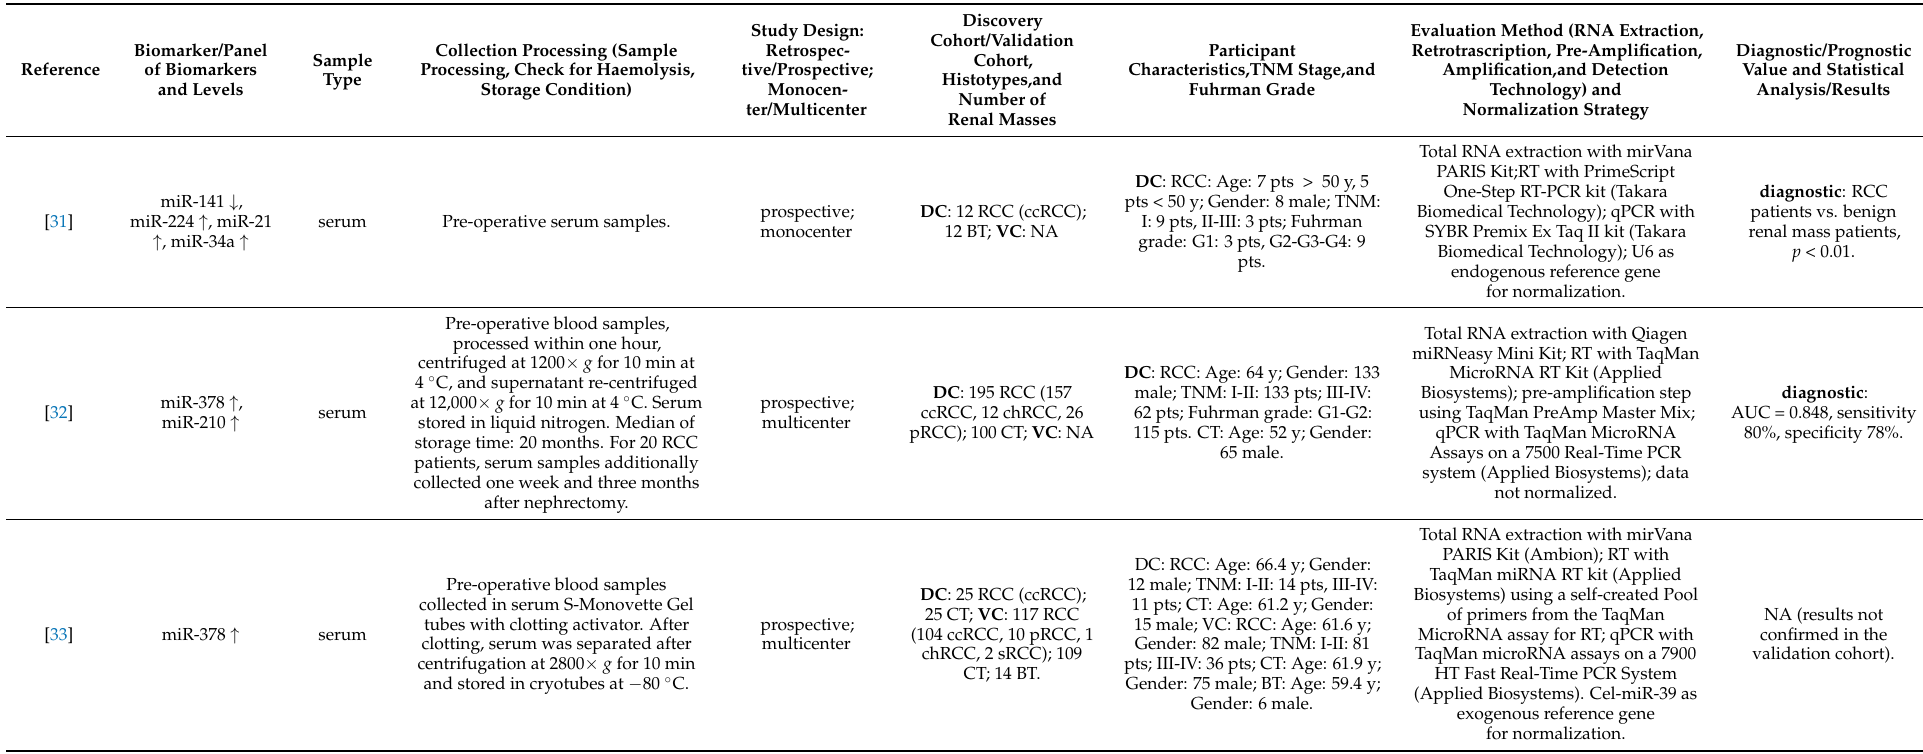
Table 1. Circulating ncRNAs as diagnostic or prognostic biomarkers in renal cell